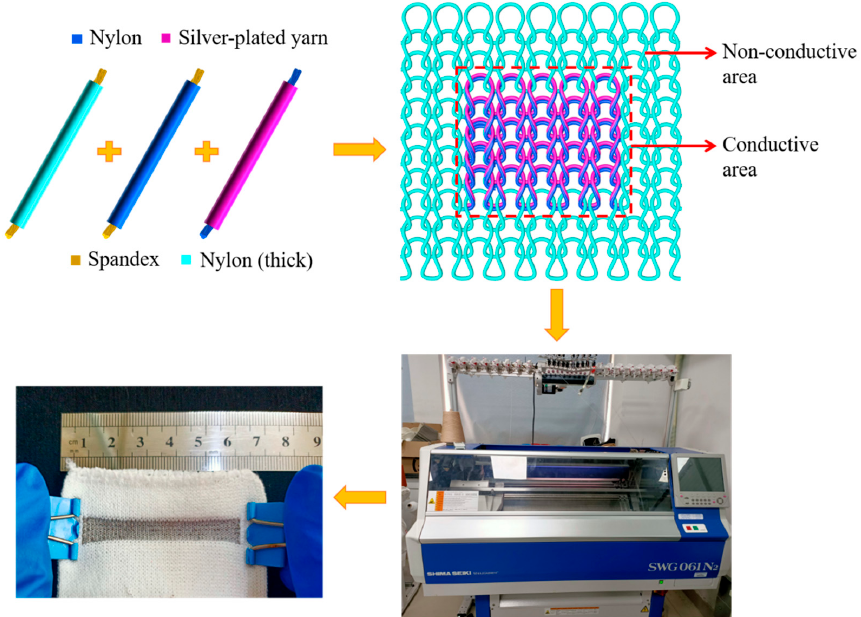
Figure 2. The fabrication process of the knitted strain sensor. Table 1. Knitting parameters of the experimental samples.